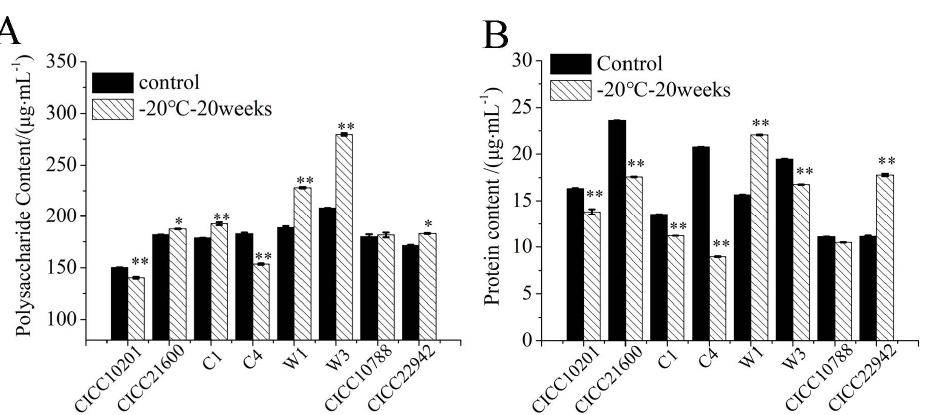
Figure 5. The polysaccharide and protein content in the biofilm matrix of S. aureus cells Note: ( A ): The polysaccharide content in the biofilm matrix of S. aureus cells. ( B ): The protein content in the biofilm matrix of S. aureus cells. S. aureus cells without cold stress were used as a control sample. The strains with cold stress were test group. **: Compared with the control group, the tested samples were significantly different ( p < 0.01), *: Compared with the control group, the treated samples were different ( p < 0.05). The values were means ± SD ( n =